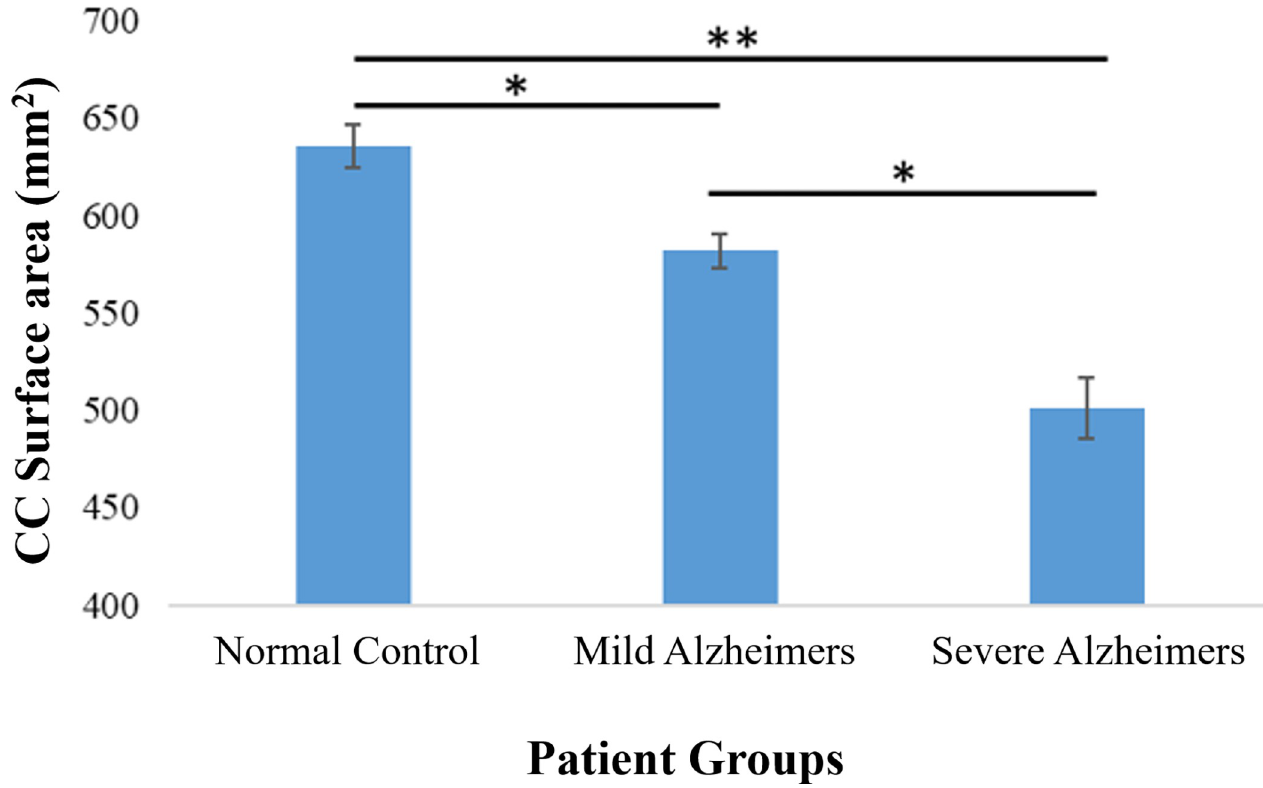
Fig 2. Adjusted corpus callosum CC mean values for the three diagnostic groups; normal controls, mild Alzheimer patients, and severe Alzheimer patients. Corpus callosum (CC) mean values were significantly smaller in Alzheimer patients compared to normal controls. Moreover, the CC area and size decreases as the severity of Alzheimer increases, thus severe Alzheimer patients have significant reduction in the CC size compared to mild Alzheimer patients. Each column represents the mean CC area ± standard error of the mean (SE). � P < 0.05, �� < 0.01 ( t